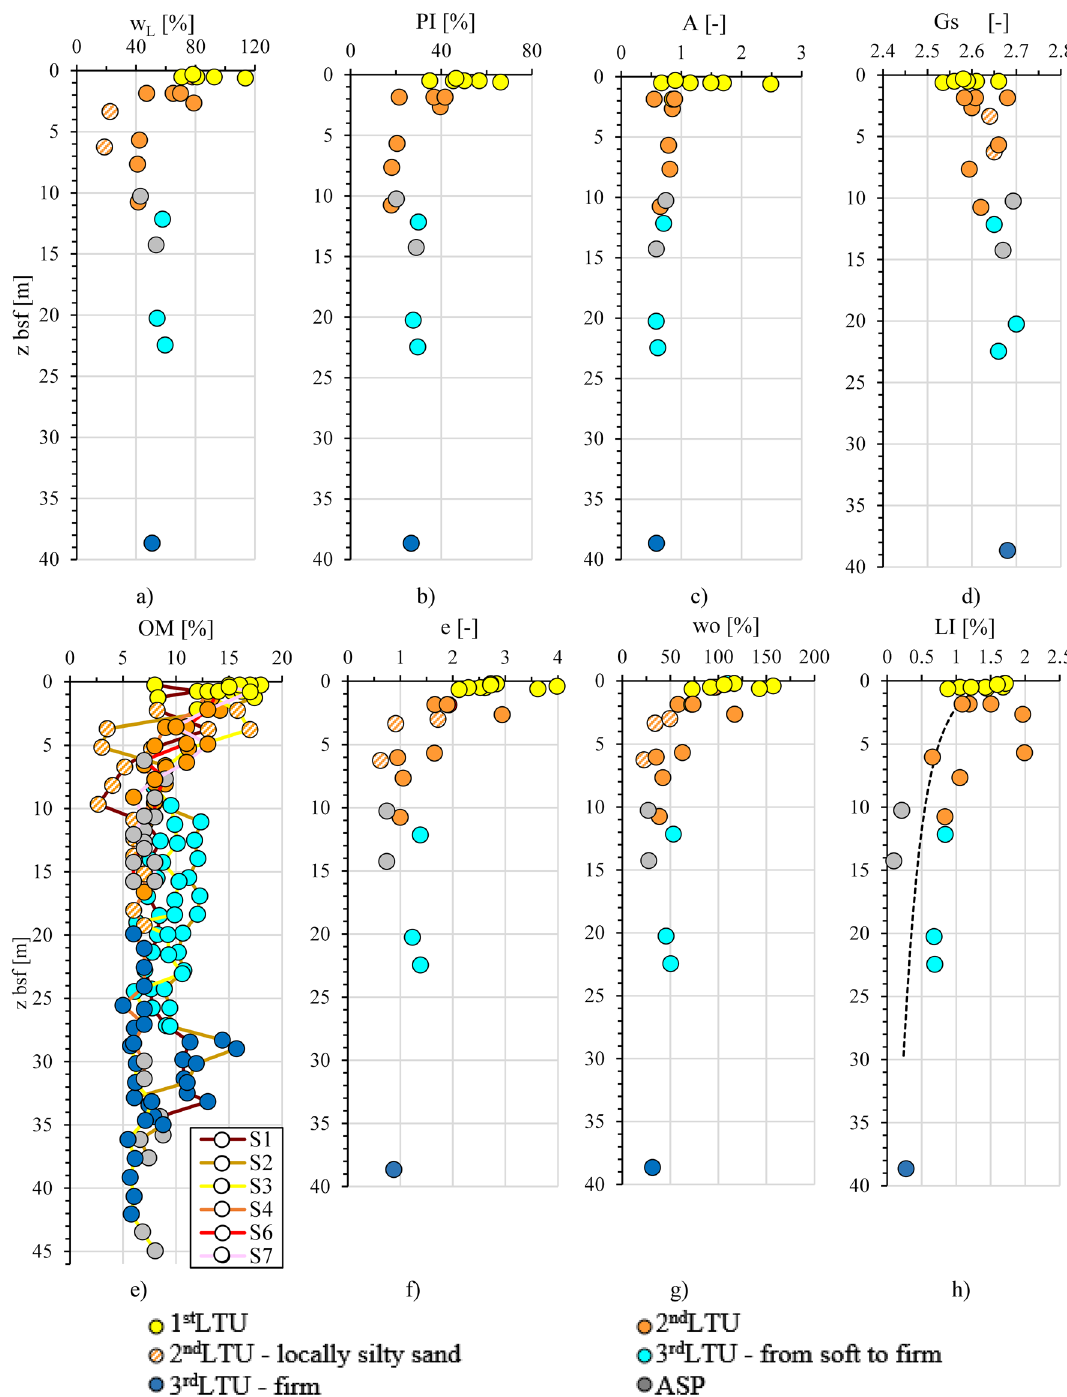
Figure 12. Profiles of chemo-mechanical properties of the samples collected within LTU s (S1, S2, S3, S4, S6, S7 close to section N–N’ in Fig. 2): ( a ) liquid limit, w L ; ( b ) plasticity index, PI; ( c ) activity index, A; ( d ) soil solid specific gravity, Gs; ( e ) organic matter, OM; ( f ) void ratio, e; ( g ) water content, w 0 ; ( h ) liquidity index, redox-processes are activated, such as anaerobic sulphate reduction (SO 42− to S 2− ) or anaerobic methanogenesis, this latter converting the CO 2 produced by the mineralisation of the organic matter, into CH 4 . The chemical data (Supplementary Table S1) plotted in Fig. 11 reveal that in the 1 st LTU , down to 1.5 m depth, some of the contaminants, either organic or inorganic, exceed either the red or the yellow thresholds cited above. In 4 of the 6 sampling sites along the section, S2, S3, S4 and S6, the concentration of metals Hg, As, Pb, Cu and Zn, either approach or exceed the Taranto Site (yellow) threshold (Fig. 11, Supplementary Table S2). In addition, values of Hg above the National Environmental Law (red) threshold are recorded at both sites S3 and S6, in the